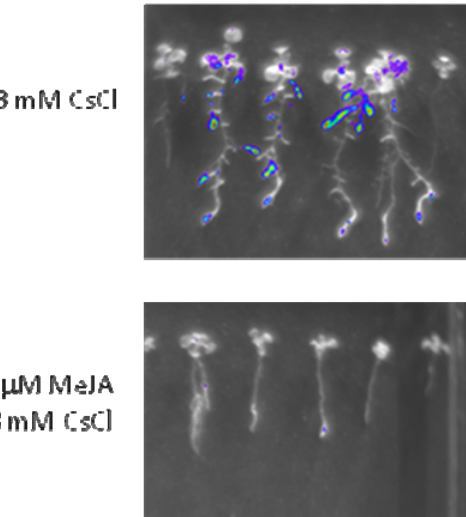
Figure 5. Chemiluminescence imaging of HAK5promoter::LUC plants grown on 1.75 mM KCl with or without 0.3 mM CsCl and 2.5 mM MeJA for 11 days. Pseudo color represents the intensity of